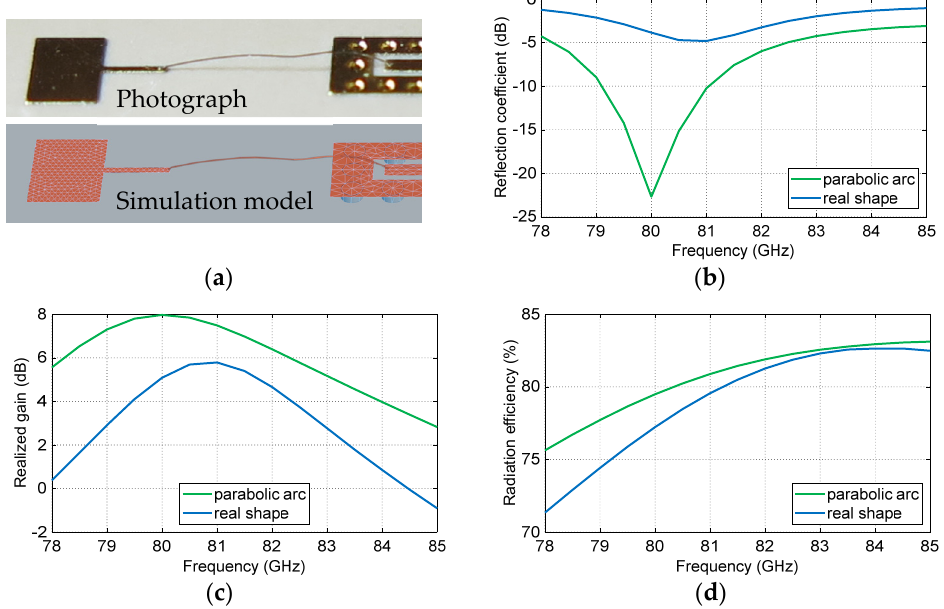
Figure 9. Simulations of two different wire bond shapes: parabolic arc of 0.1 mm height and real bond shape of 0.23 mm height ( a ) photograph of the manufactured structure and the model with real bond shape; ( b ) reflection coefficient; ( c ) realized gain (reflection loss included), broadside direction; ( d ) radiation efficiency.